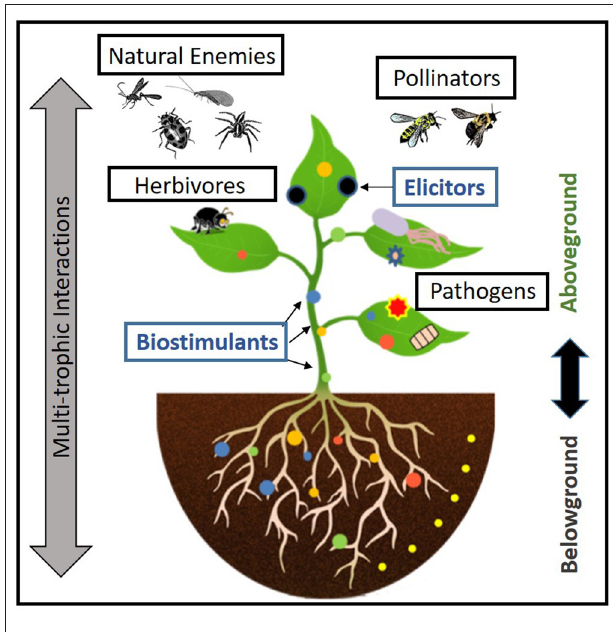
FIGURE 1 | A multi-organismal and multi-disciplinary approach for studying host-plant resistance against insect pests is needed that incorporates multi-trophic insect-microbial-plant interactions aboveground and belowground. Elicitors of the jasmonic acid and salicylic acid pathways and biostimulants such as growth promoting rhizobacteria and humic acids offer ways to enhance plant defense responses and improve plant growth. Drawings by S. K. Dara and R.